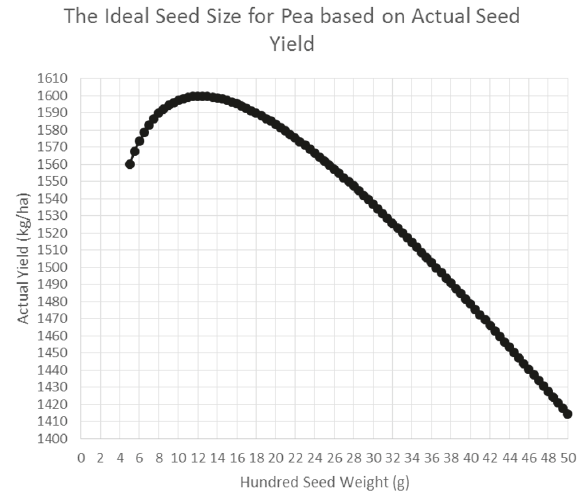
Figure 2: The ideal seed size for pea in Montana. The ideal seed size is at the vertex of the